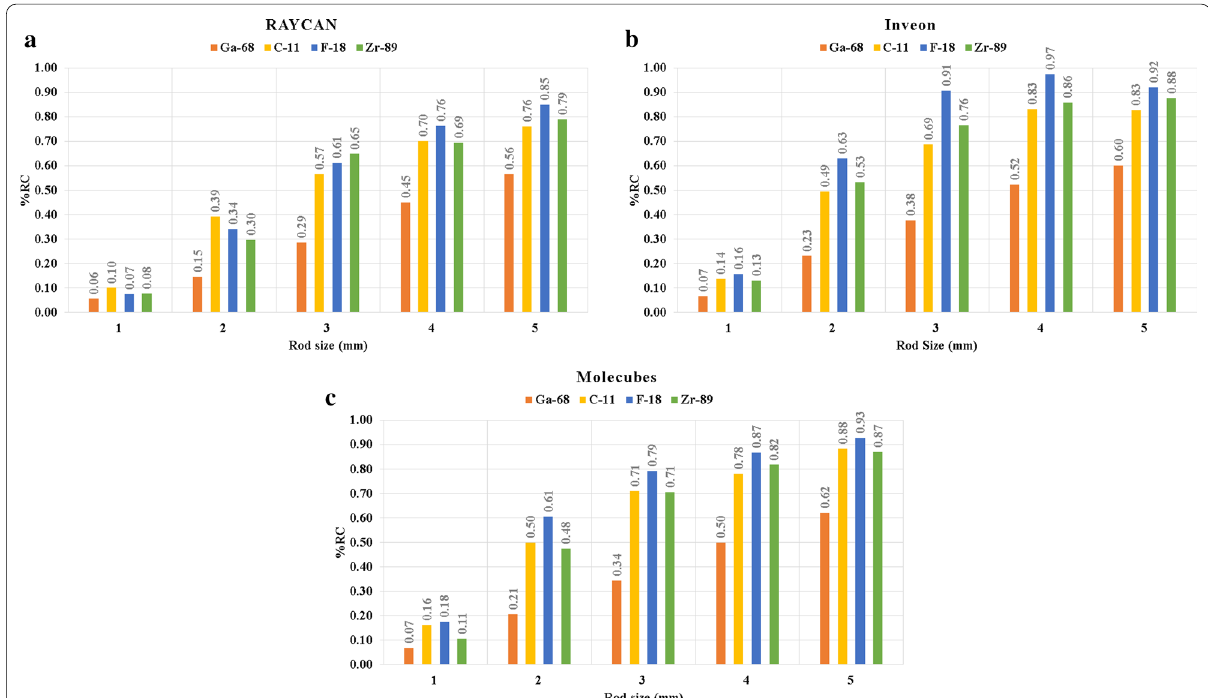
Fig. 2 Recovery coefficients (%RC) with different radionuclides with the a RAYCAN, b Inveon and c Molecubes systems. The maximal recovery is achieved with 18 F. 11 C and 89 Zr are close to the values with 18 F. 68 Ga shows the lowest recovery on all systems and rod